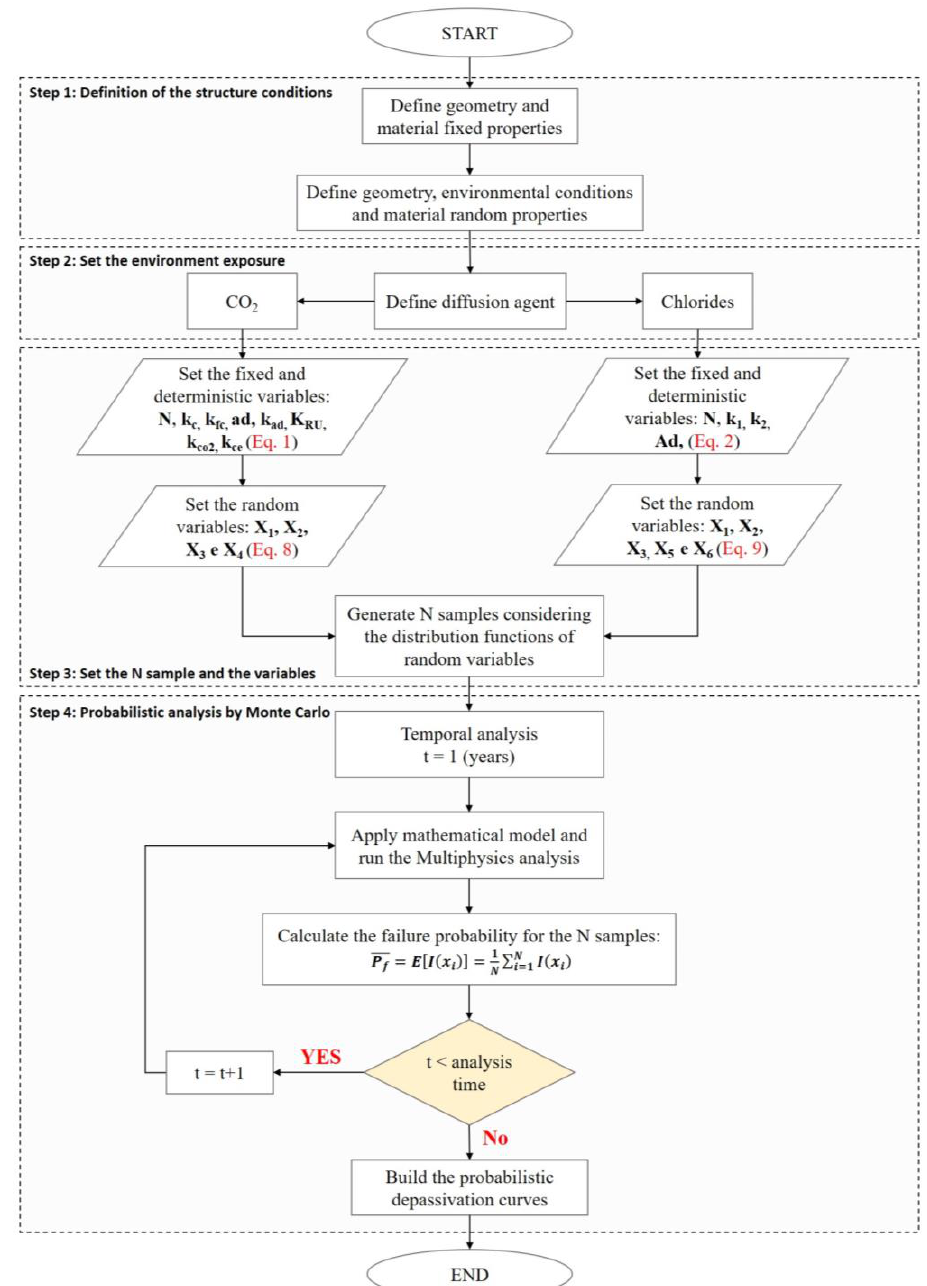
Figure 2. Flow chart of the probabilistic approach.